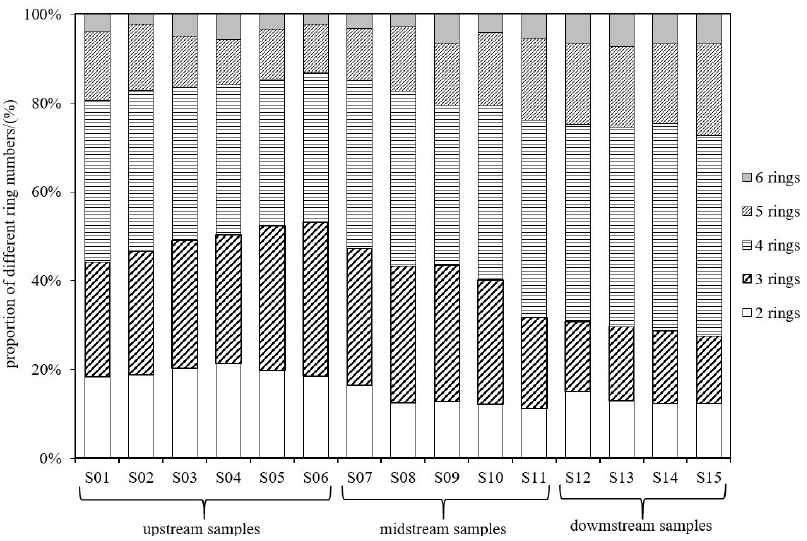
Figure 3. Composition distribution of PAHs in groundwater